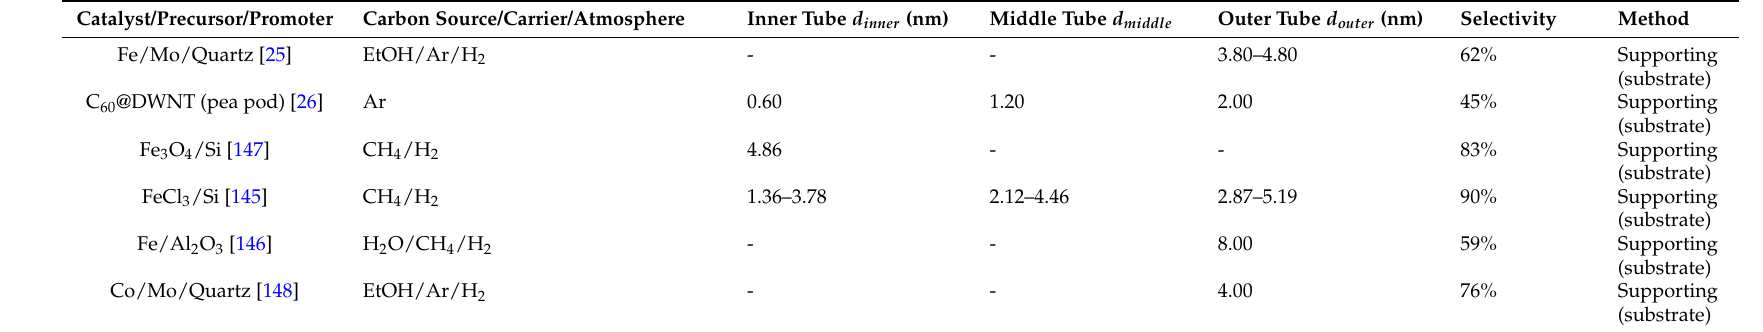
Table 2. Synthesis methods for the selective growth of triple-walled carbon nanotubes